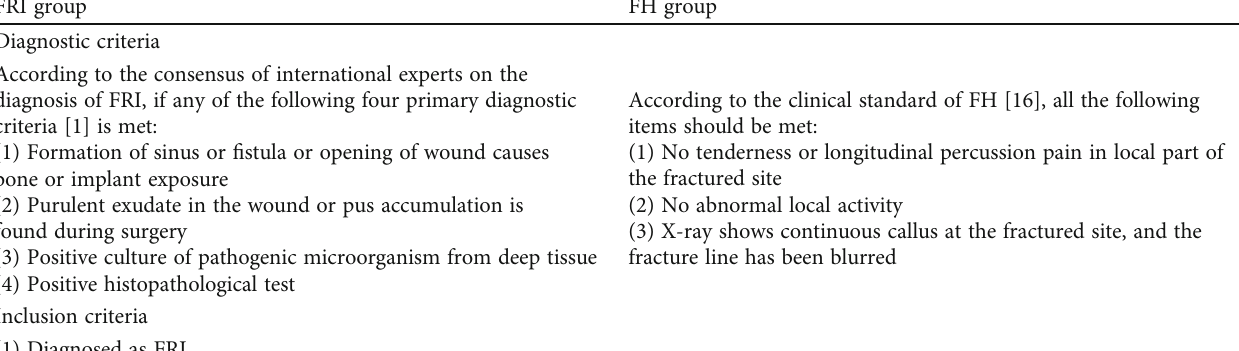
Table 1: The diagnostic criteria, inclusion and exclusion criteria for FRI group and FH group. FRI group FH